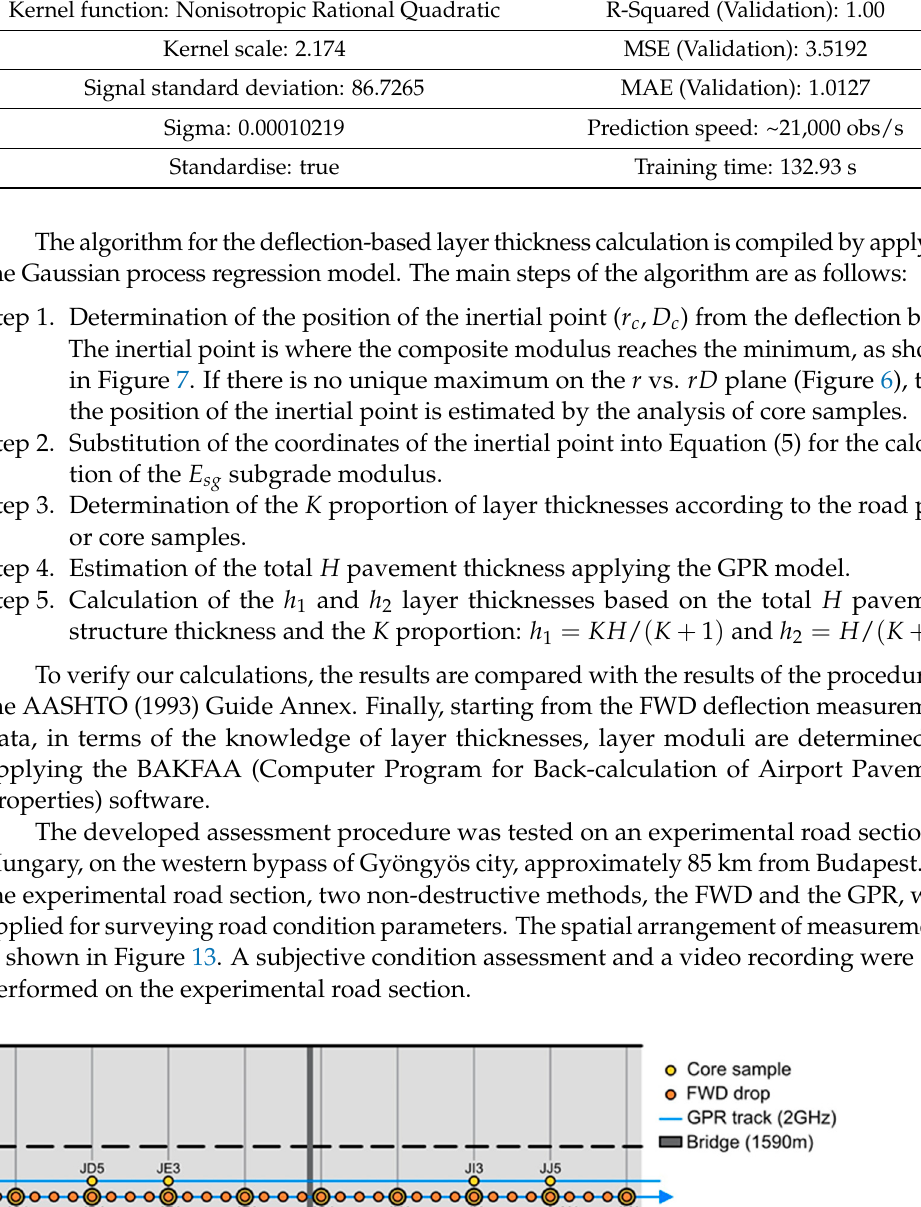
Figure 14. Recording road defects by visual inspection. The KUAB-type FWD device (Figure 1) has a load plate radius of 150 mm, and the distances of the seven sensors from the load axis are: 𝑟 (cid:2868) = 0 , 𝑟 (cid:2869) = 200 , 𝑟 (cid:2870) = 300 , 𝑟 (cid:2871) = 450 , 𝑟 (cid:2872) = 600 , 𝑟 (cid:2873) = 900 , and 𝑟 (cid:2874) = 1200 mm. The KUAB device stores 𝐷 (cid:2868) , 𝐷 (cid:2869) , 𝐷 (cid:2870) , 𝐷 (cid:2871) , 𝐷 (cid:2872) , 𝐷 (cid:2873) , and 𝐷 (cid:2874) deflections at sensor positions as a reaction of the 50 kN load force. In the middle of the lane of the surveyed section, every 25 m, two drops were performed: a pre- loading and a measurement. At each point beside the deflection data, the load force was recorded, as well as the air and pavement temperatures. All deflection data were after- wards corrected to a 50 kN load. The georadar device for the survey was provided by the RODEN Engineering Office, Hungary (Figure 15). The GSSI-type 1 GHz and 2 GHz frequency air-connected antennas are situated behind the measurement car at 1.5 m, above the pavement surface at approx- imately 250 mm. The position of the antennas is shown in Figure 15. The survey was per- formed at 16 km/h speed and 50 scan/m. The raw data were recorded by a high-speed multi-channel SIR-30 data recorder and controller system. In the present paper, only the results of the 2 GHz antennas are processed and evaluated by applying the RADAN soft- ware. For comparison, the layer order of the surveyed road section was determined by us- ing destructive methods every 100 m (Figure 16). The core sampling technology proved